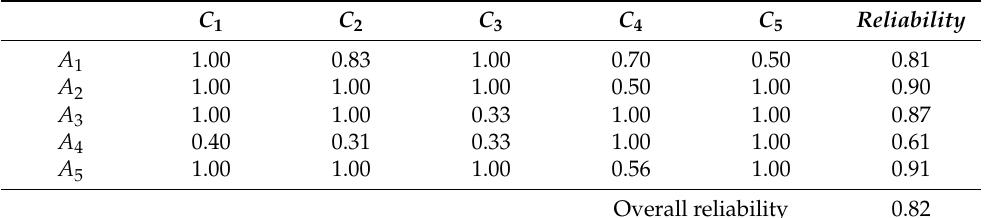
Table 15. The reliability of information obtained from the first of three respondents.